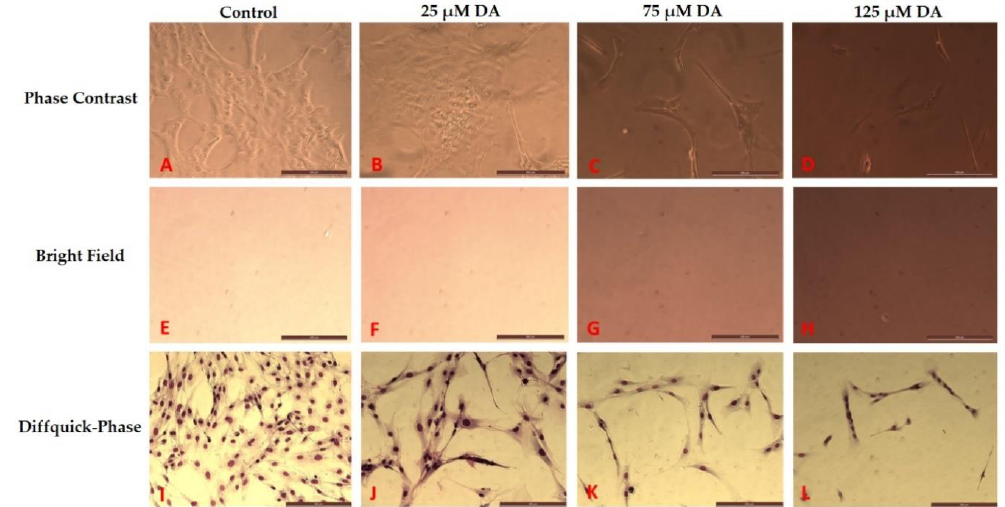
Figure 7. Morphological changes in astrocytes related to formation of PDA prior to cell plating. Astrocytes at a density of 5000 per well, were introduced to wells which had already been treated with dopamine and ongoing polymerization of DA to PDA at the indicated concentrations. Scale bars indicate 200 µm. Panels ( A – D ) show phase contrast images of astrocytes (untreated and treated with dopamine, 72 h post plating). Panels ( E – H ) show bright field images of the same fields as in panels ( A – D ). Panels ( I – L ) show Diffquik stained astrocytes (untreated control and treated with dopamine) 72 h post plating.